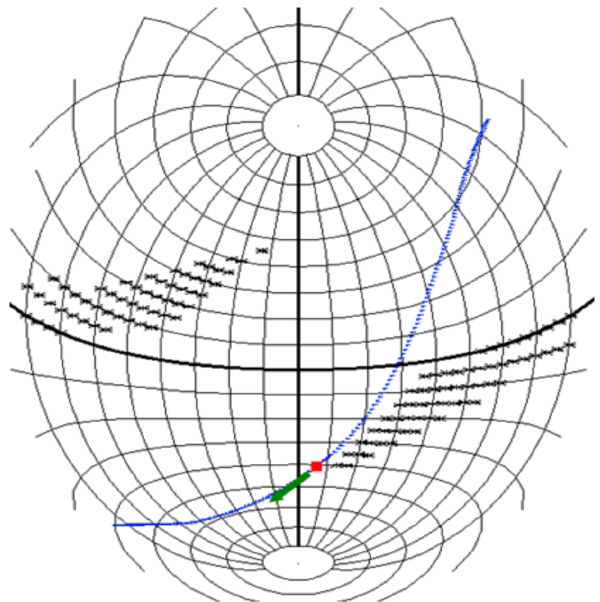
Fig. 8. Front view of the magnetopause. The red cross represents the location of Cluster spacecraft at 18:00UT. The blue line repre- sents the IMF line passing by Cluster spacecraft. The regions in- dicated by black crosses are regions of high magnetic shear where antiparallel reconnection models expect reconnection to occur. The green arrow indicated the direction of convection at Cluster location as obtained by the dHT analysis. The reconnection site is estimated to lie in a region located in the opposite direction of the convection velocity at some tens of R E from Cluster